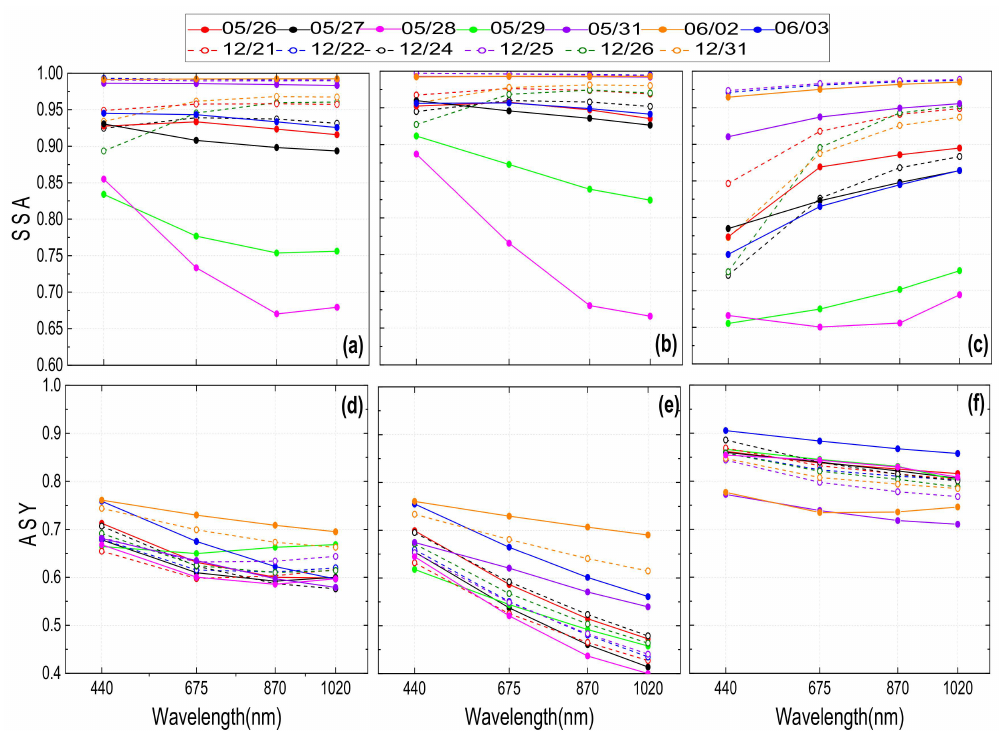
Figure 6. Spectral variation of SSA (single scattering albedo) and ASY (asymmetry factor) during the two pollution episodes ( a , d ) total mode, ( b , e ) fine mode, ( c , f ) coarse mode.